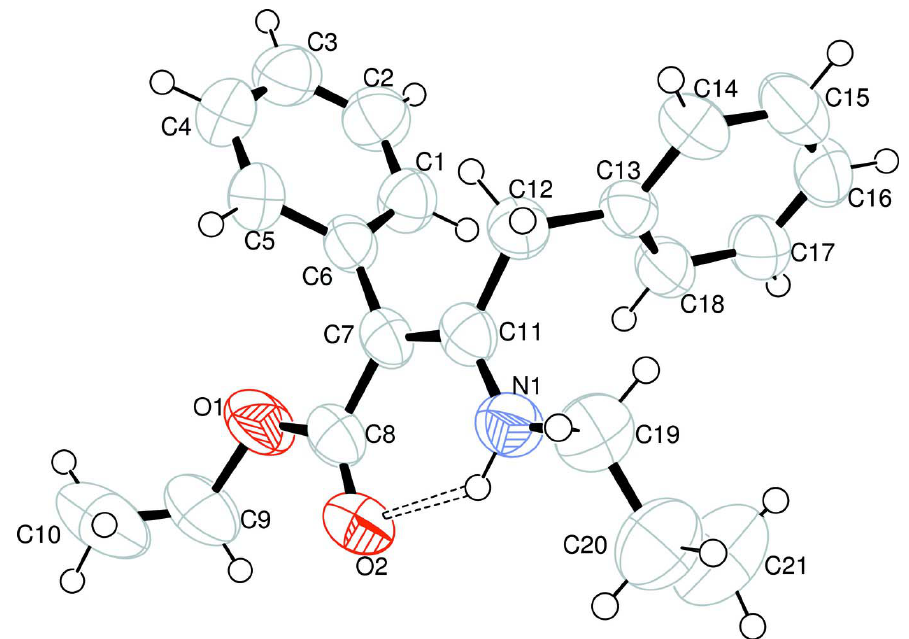
Figure 1 The molecular structure of (I) with 50% probability displacement ellipsoids. The dashed line indicates the intramolecular N—H···O hydrogen